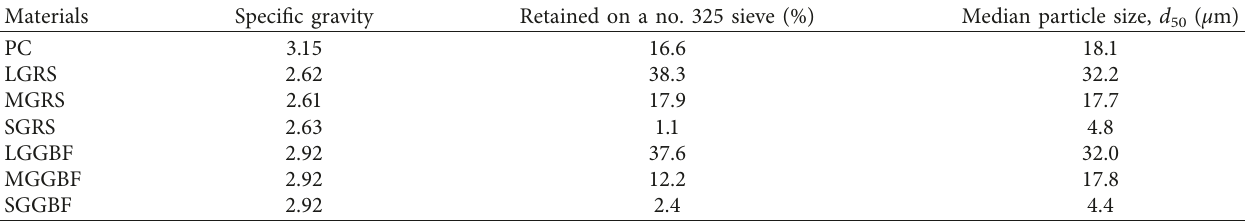
Table 1: Physical properties of PC, GRS, and GGBF slag.